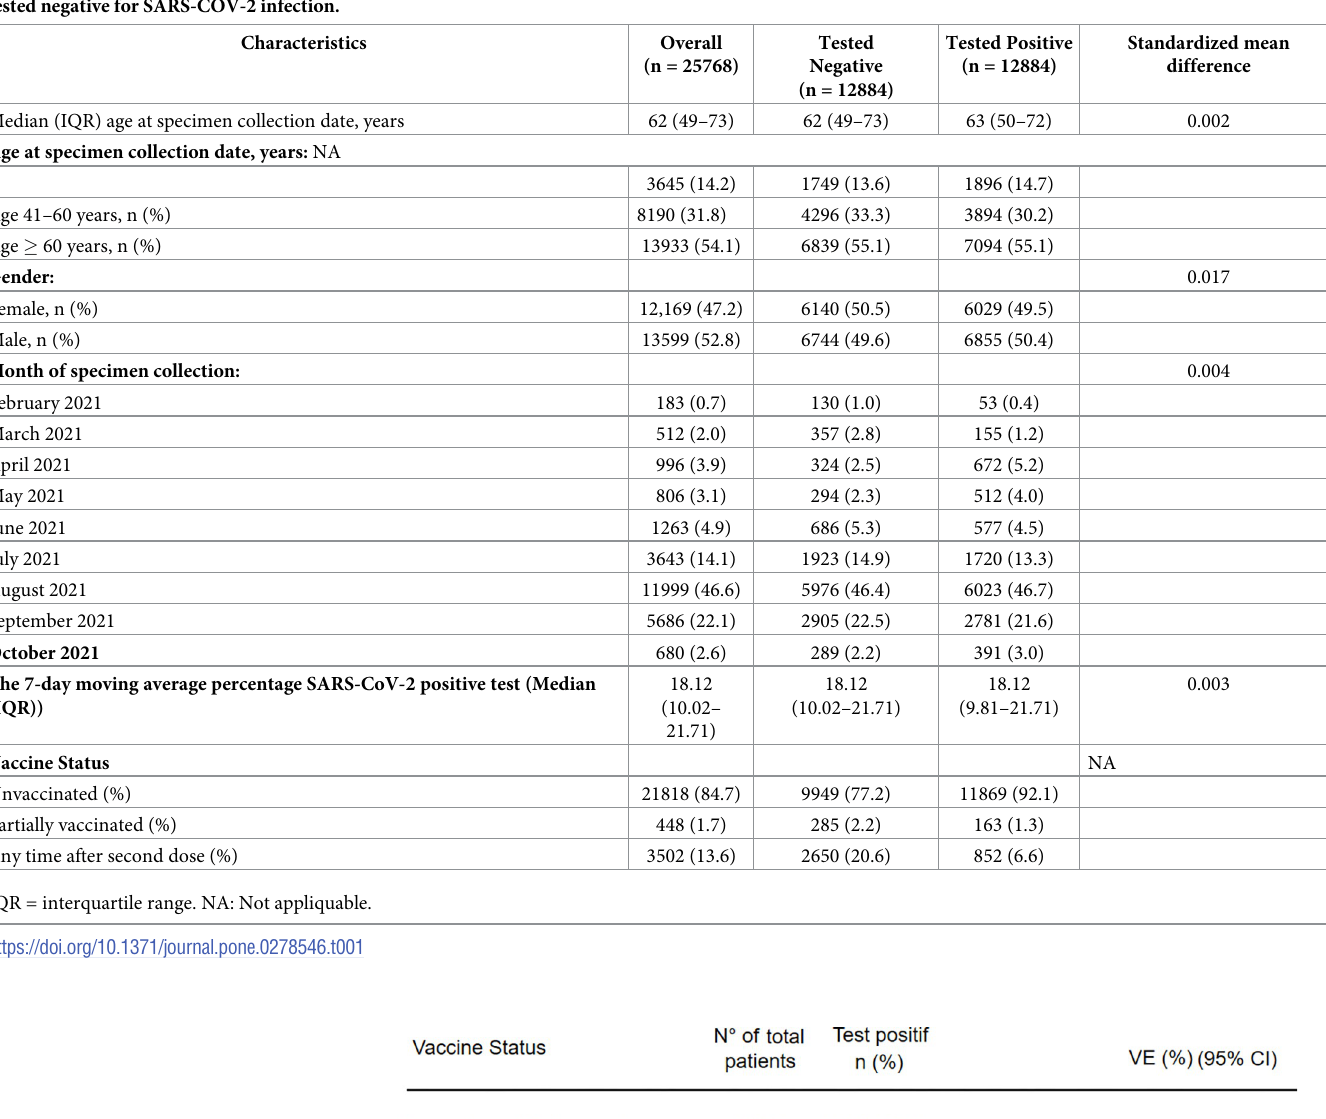
Table 1. Baseline characteristics of individuals tested positive for SARS-COV-2 infection by rt-PCR test and Propensity Score–Matched control participants who tested negative for SARS-COV-2 infection.